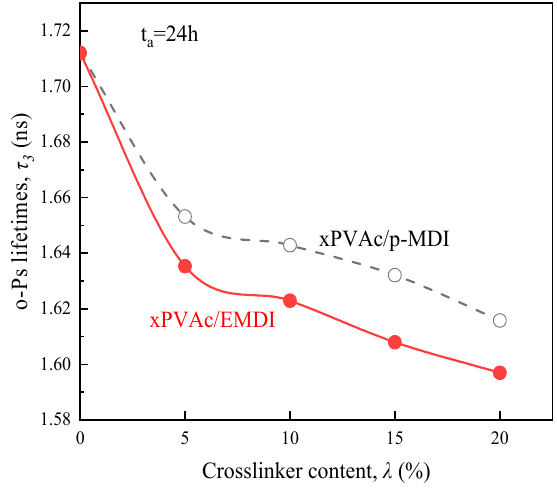
Figure 7. Effect of isocyanate crosslinkers on the lifetimes τ 3 of o-Ps in aging EPI film. Figure 7. E ff ect of isocyanate crosslinkers on the lifetimes τ 3 of o-Ps in aging EPI